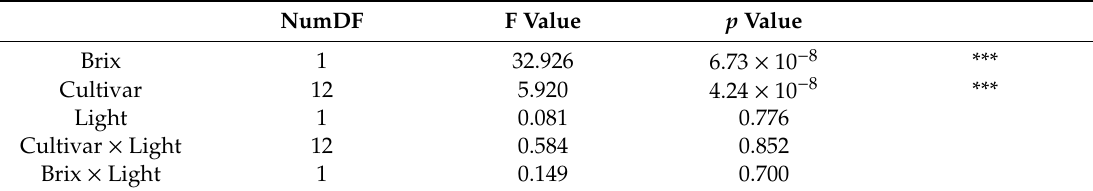
Table 6. Analysis of Variance table for significant glucose correlation to brix, cultivar, light, brix × light, and cultivar × light. Asterisks indicate p -value significant at 0.001.